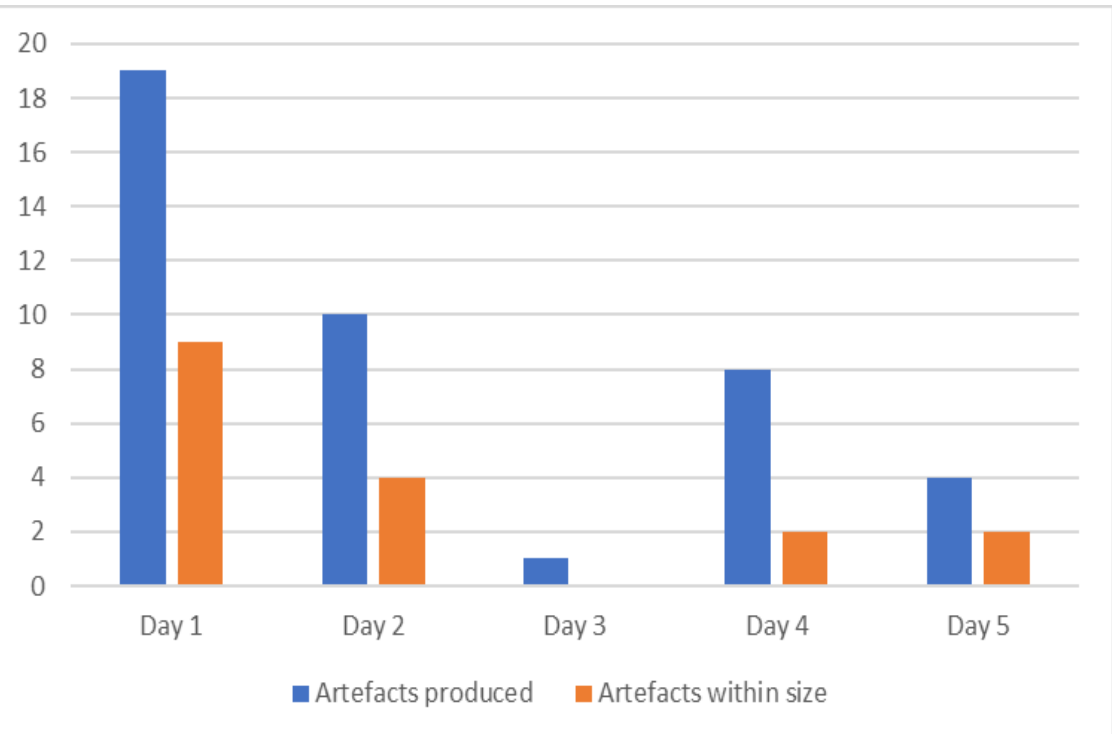
Figure 2. Total artefacts produced compared to pieces within the projects size parameters (chart produced by the